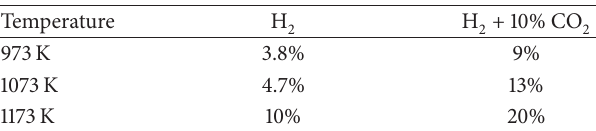
Table 2: Maximum methane molar content in the outflow gas in Table 3: Comparison of the maximum molar methane content in the outflow